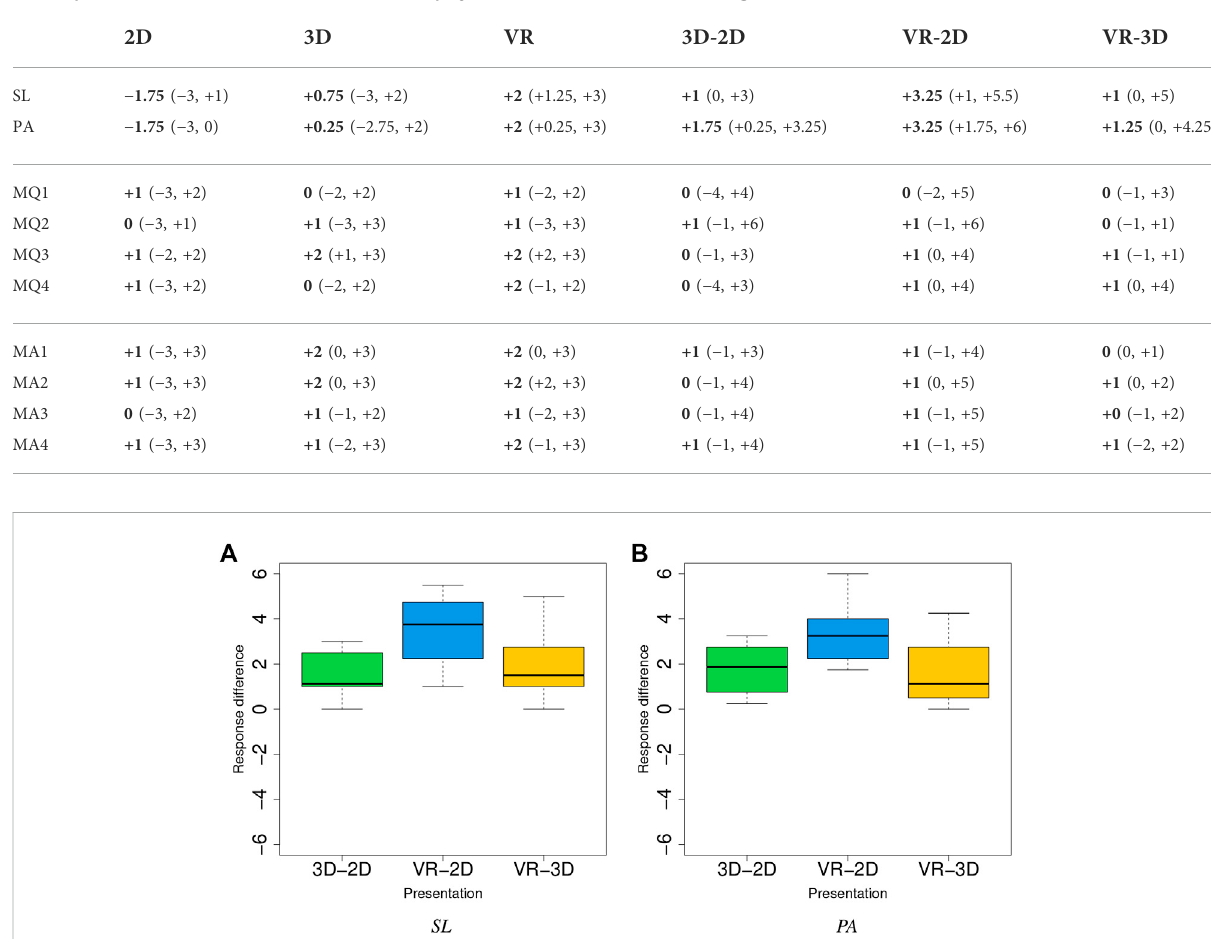
TABLE 1 Median (bold) and range (min, max) for obtained data from the SPES questionnaire, MA and MQ. 2D, 3D and VR are the three levels of the factor “ presentation ” . 3D-2D, VR-2D and VR-3D display the individual difference in rating.